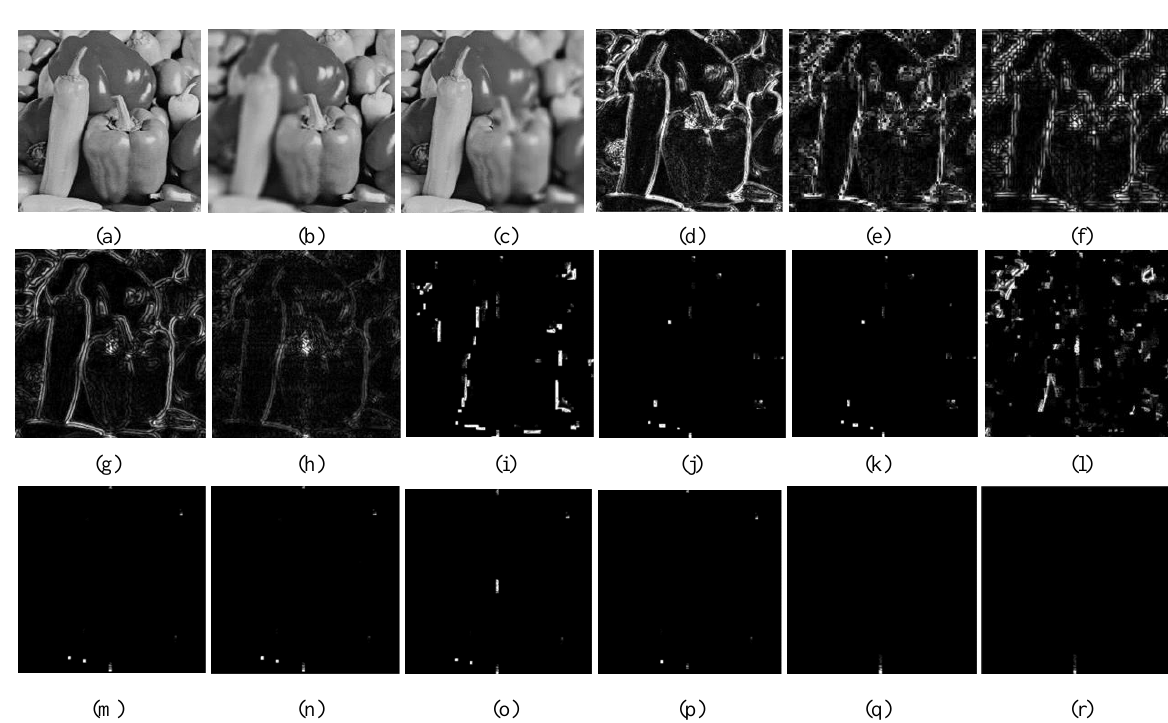
Figure 7. Source images and multi-focus images of “Pepper”, and difference images between ground-truth image and fused output images of proposed methods and other methods. (a) Ground-truth image. (b) First source image with focus on the right. (c) Second source image with focus on the left. (d) DCT+Average. (e) DCT+Contrast. (f) DWT. (g) SIDWT. (h) DCHWT. (i) DCT+Variance+CV. (j) DCT+Ac_Max+CV. (k) DCT+SF+CV. (l) DCT+SML+CV. (m) DCT+EOL+CV (Proposed). (n) DCT+VOL+CV (Proposed). (o) DCT+Corr+CV (Proposed). (p) DCT+Eng_Corr+CV (Proposed). (q) DCT+VOL+RCV (Proposed). (r) DCT+Eng_Corr+RCV